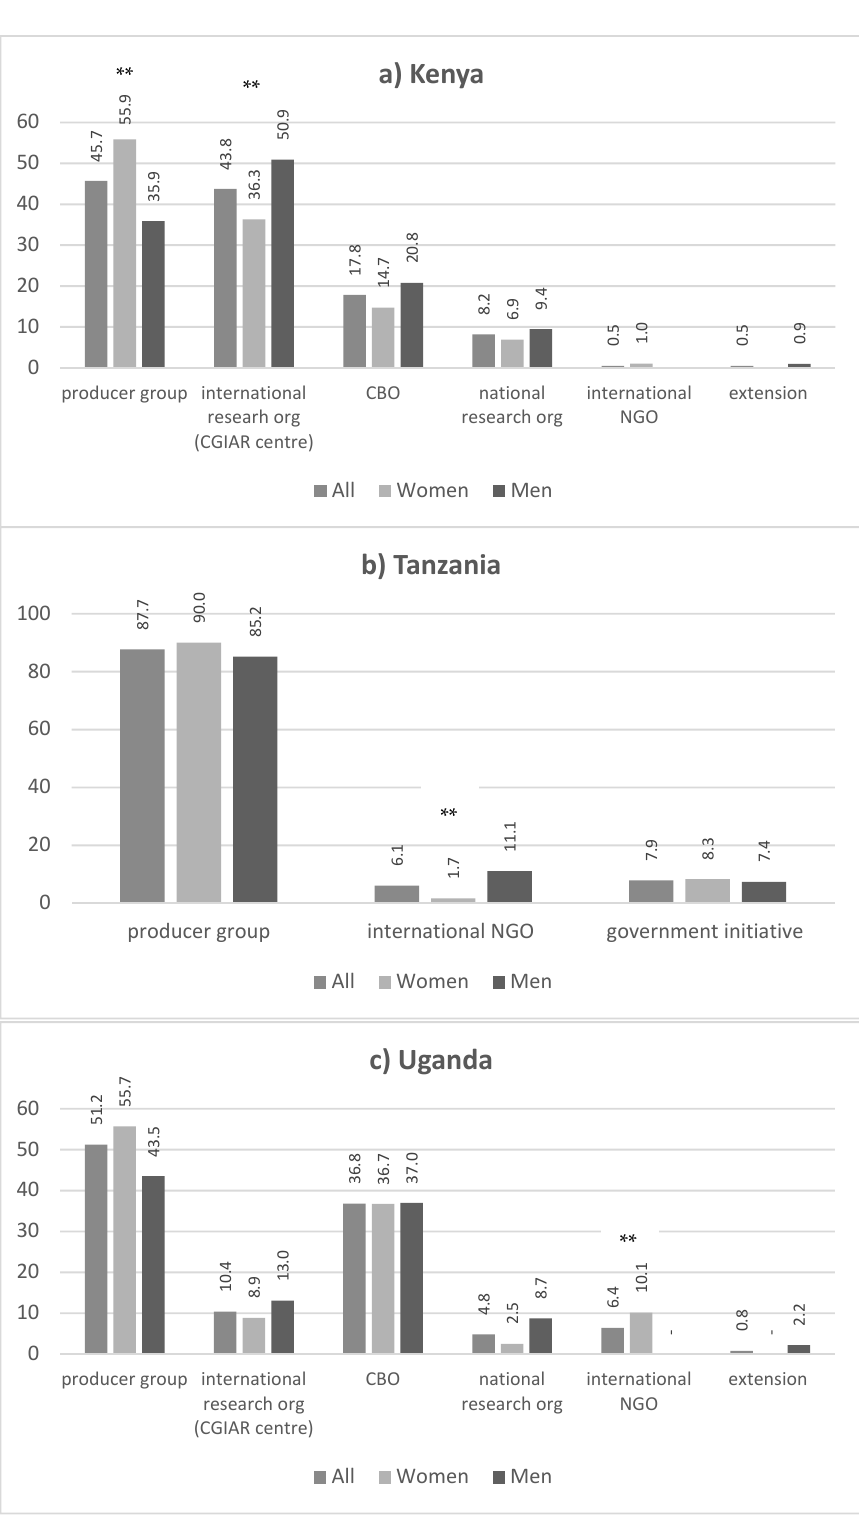
Figure A2. Formal institutions used as seed sources, by sex and country (% of respondents) in ( a ) Uganda, ( b ) Kenya and ( c ) Uganda. Overall, chi square tests show a significant association between the seed sources and respondent sex in Kenya and Uganda at the 5% level. ** indicates a significant difference in the proportion of men and women who mentioned that seed source at the 5% level using t